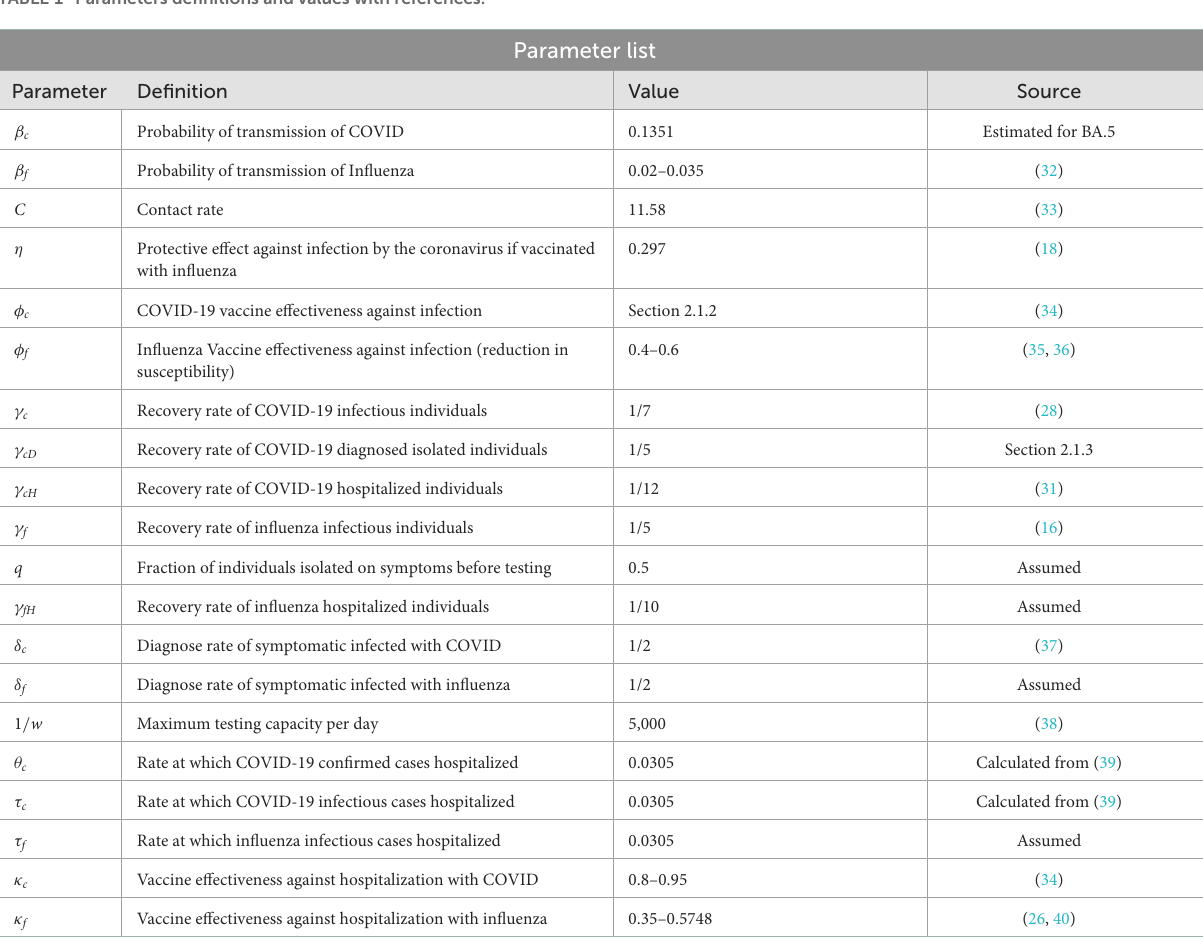
TABLE 1 Parameters definitions and values with